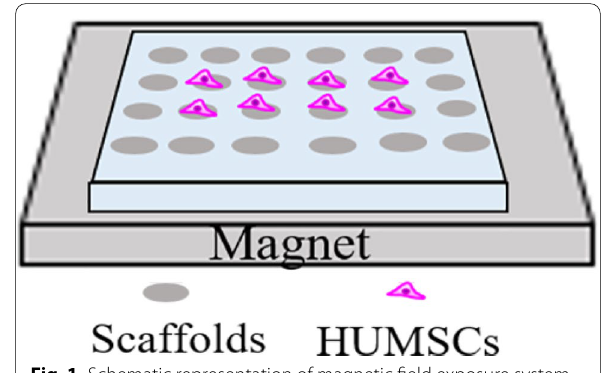
Fig. 1 Schematic representation of magnetic field exposure system